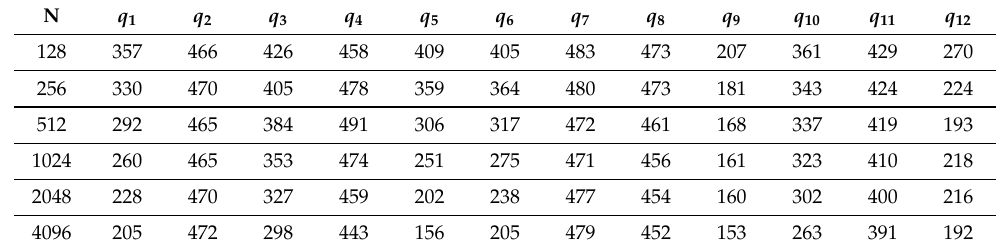
Table 3. Mean ¯ R (multiplied by 10 3 ) for all models and all NLERs.